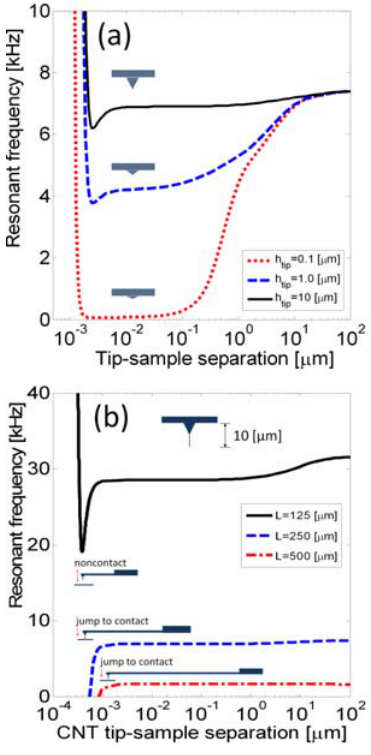
Figure 3. Frequency versus tip-sample separation for ( a ) probes with various tip heights, and ( b ) a CNT-tip with various microcantilever